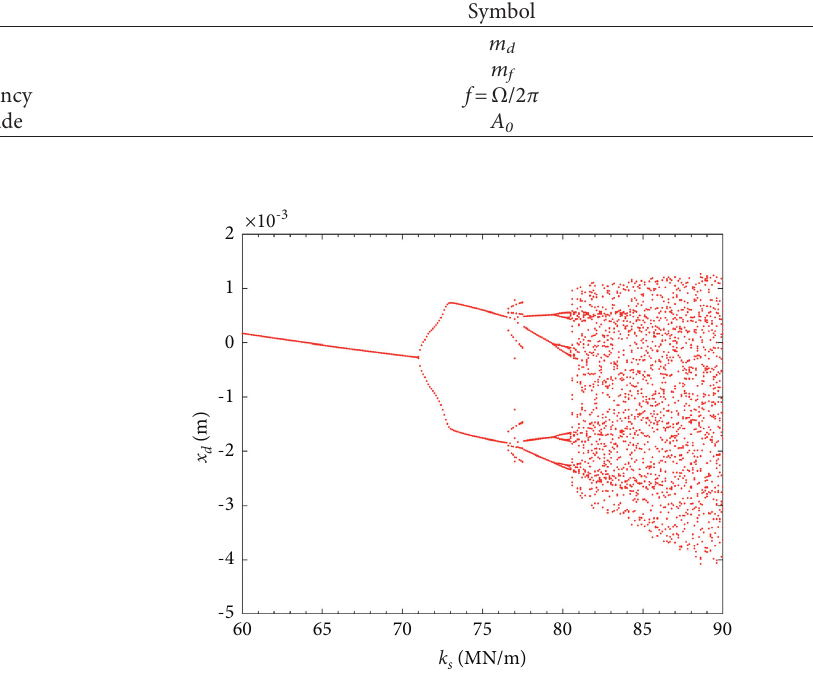
s as the bifurcation parameter.